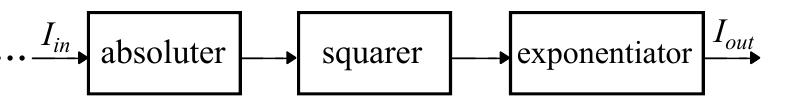
Figure 5. Design flow diagram for the implementation of the Gaussian function based on the translinear